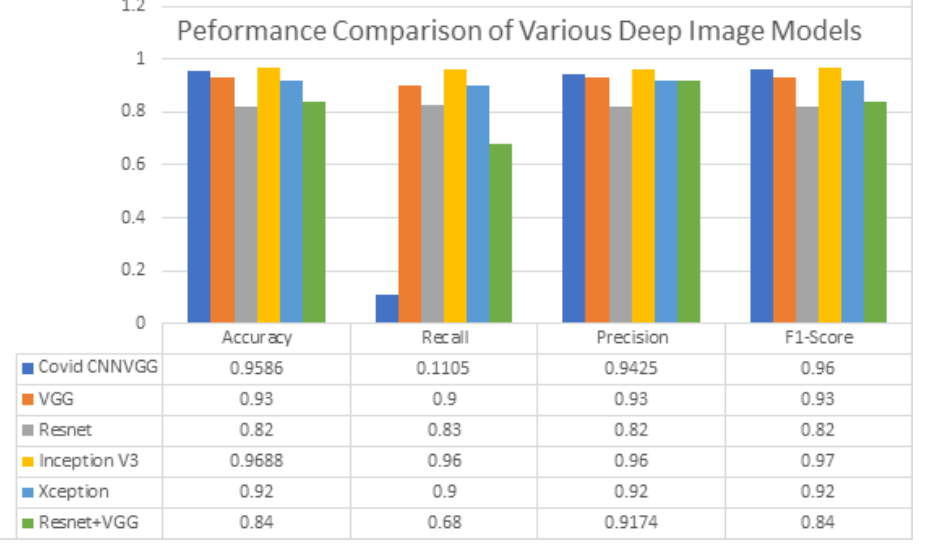
Figure 9. Comparative analysis of all the models of deep neural networks used for COVID-19 X-ray